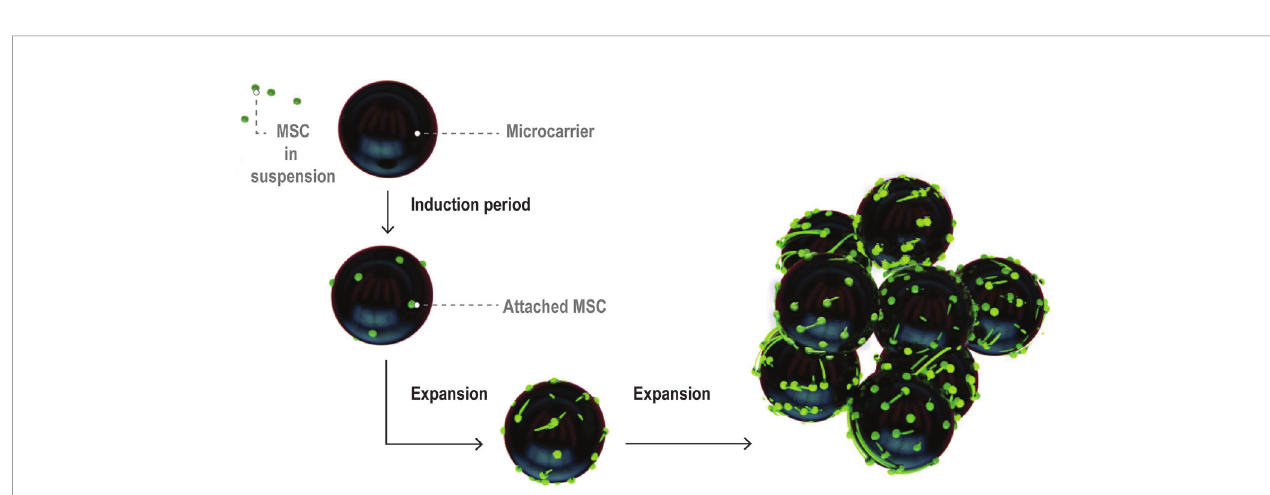
FIGURE 4 | Visual representation of MSC expansion on microcarriers over time within a bioreactor. Figure adapted from (Caruso et al., 2014). MSCs initially attach at low coverage in a rounded morphology then fl atten and spread over the induction period. The cells then enter a growth phase and expand to cover a large proportion of the microcarrier surface area.